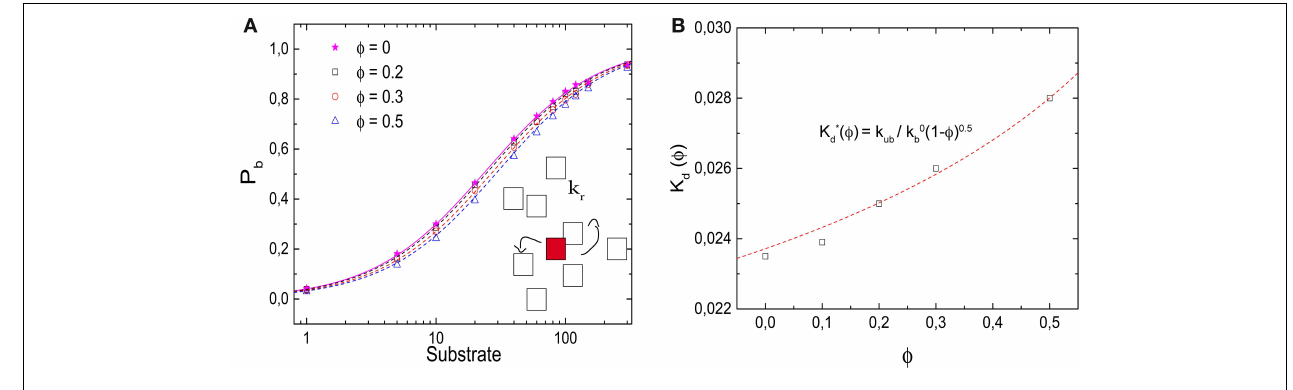
the reaction model, in which a product P is synthesized with a rate k r . (B) Dissociation constant K * d ( φ ) (obtained as the substrate concentration for which P b 0 . 5 ) as a function of φ , which increases as a function of φ . The 0 , 0 . 2 , 0 . 3 , and 0 . 5 . Molecular = = line is obtained from Equation (7) with κ 0 . 5 , as obtained from the fit in = Figure 6B . Simulation parameters as in Figure 2 , and k r 1 / 60 τ − 1 =